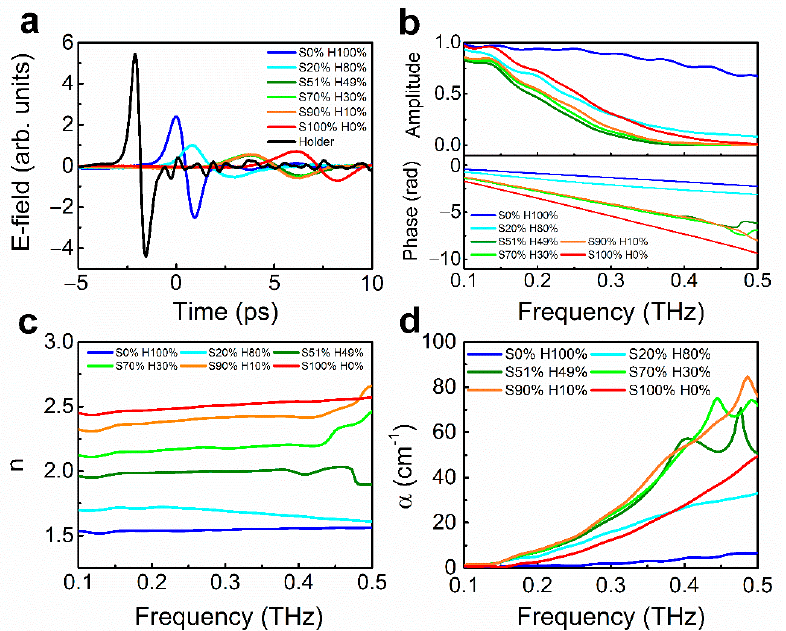
Figure 3. Extraction of refractive indices and absorption coefficients for a mixture of HDPE and salt with various compositions. ( a ) Terahertz time traces, ( b ) amplitude and phase spectra, ( c ) refractive indices, and ( d ) absorption coefficients for various mixtures of HDPE and salt, respectively.